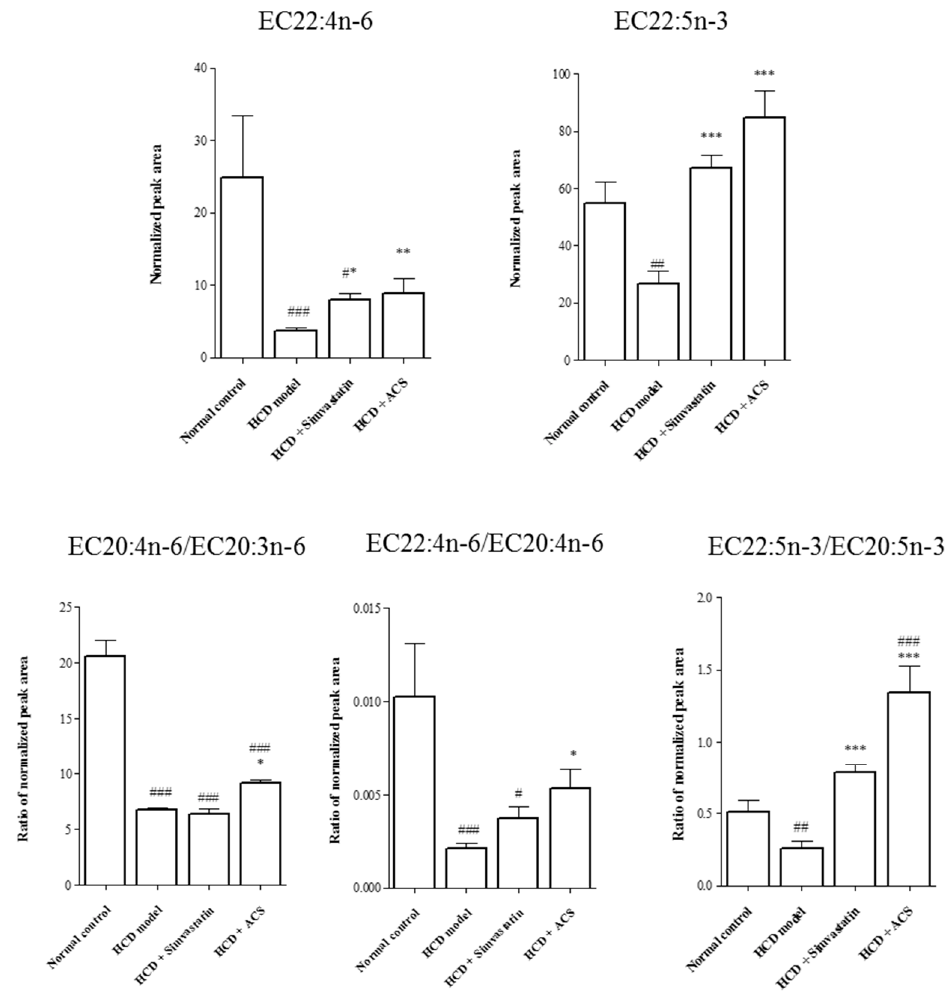
Figure 7. The normalized serum levels of EC22:4n-6, EC22:5n-3, and ratio of EC20:4n-6/EC20:3n-6, EC22:4n-6/EC20:4n-6 and EC22:5n-3/EC20:5n-3. Data are expressed as means ± SEM, ( n =